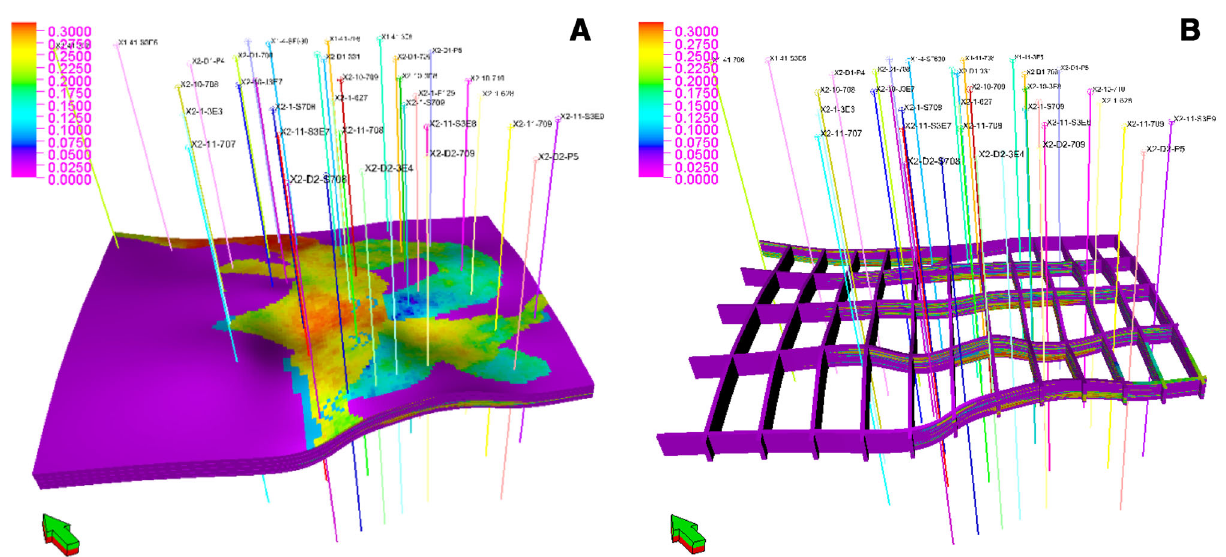
Fig. 9 Porosity models in the study area. a Porosity model of the S2 layer set in the study area; b porosity fence model of the S2 layer set in the study area